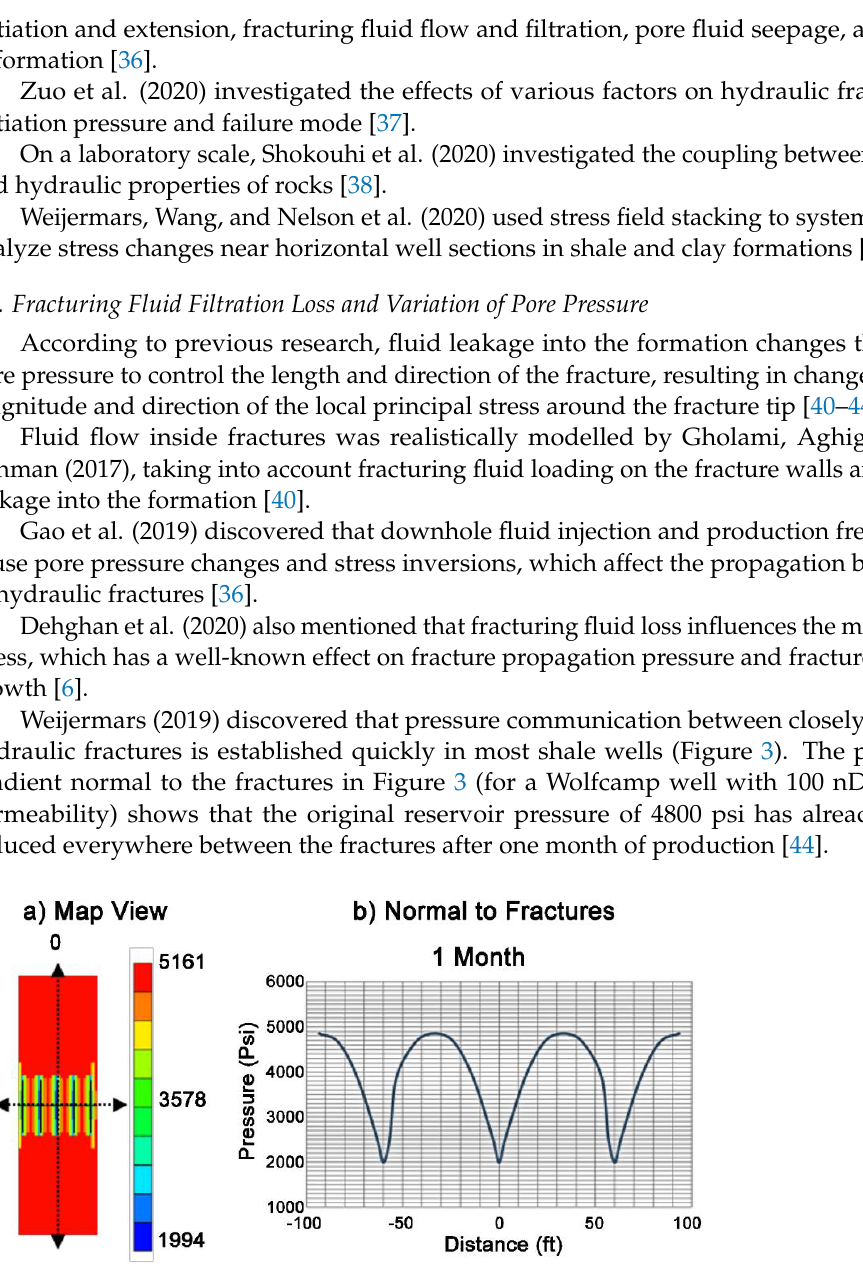
Figure 3. Pressure depletion (psi) progression for the central three fractures in a Wolfcamp shale well (Midland Basin, West Texas) constructed using a production history-matched CMG model. ( a ) Map views of pressure depletion in production bench with wellbore horizontal in image and transverse fractures sets spaced at 60 ft. ( b ) Pressure gradient normal to the fractures after 1 month [44]. (Reproduced with permission from Elsevier, 2019).